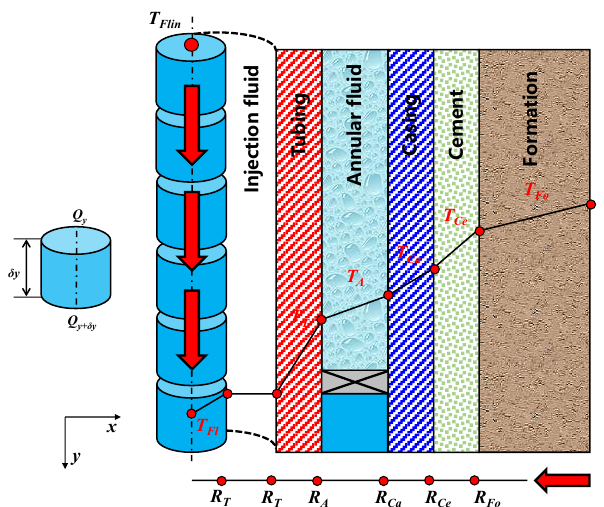
Figure 1. The physical model of the injection fluid and heat transfer in the borehole.